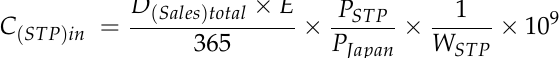
Table 3. Annual antimicrobial usage in the survey area [34–36]. Antimicrobials